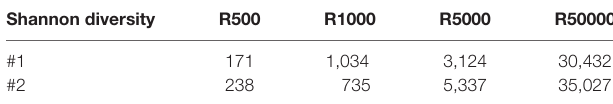
TaBle 1 | Shannon diversity calculated for each dataset.